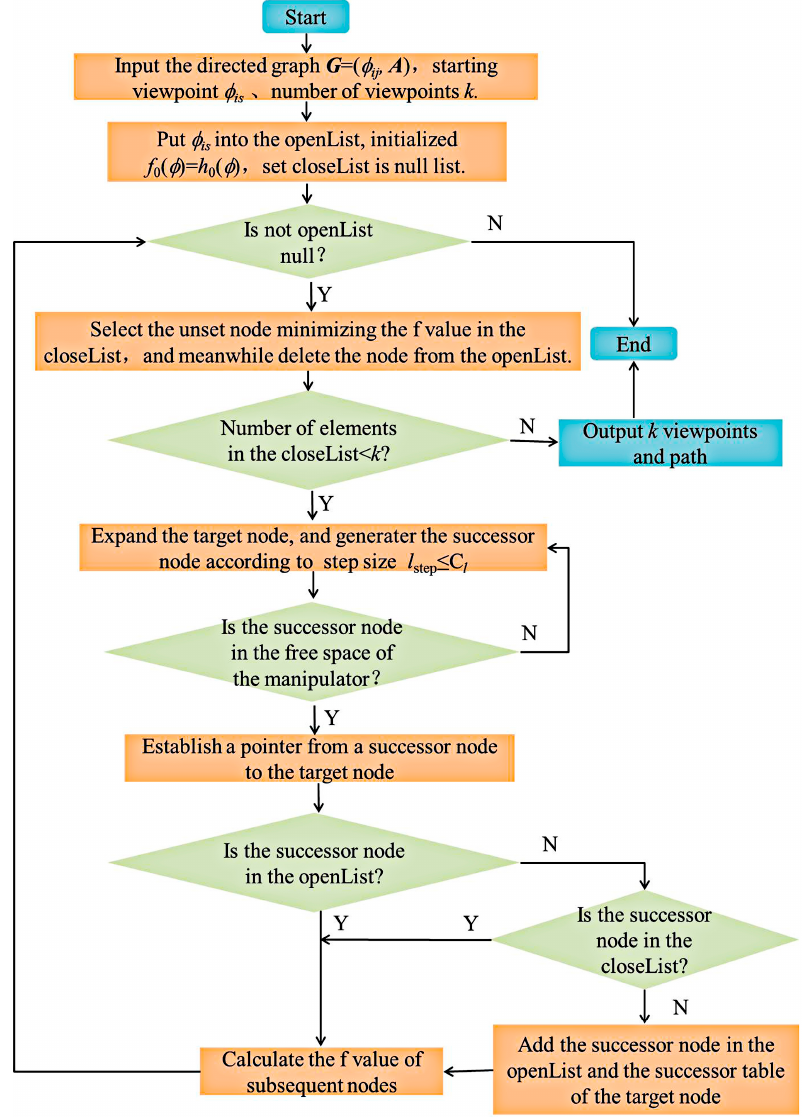
Figure 6. Path planning flow chart based on A* algorithm.